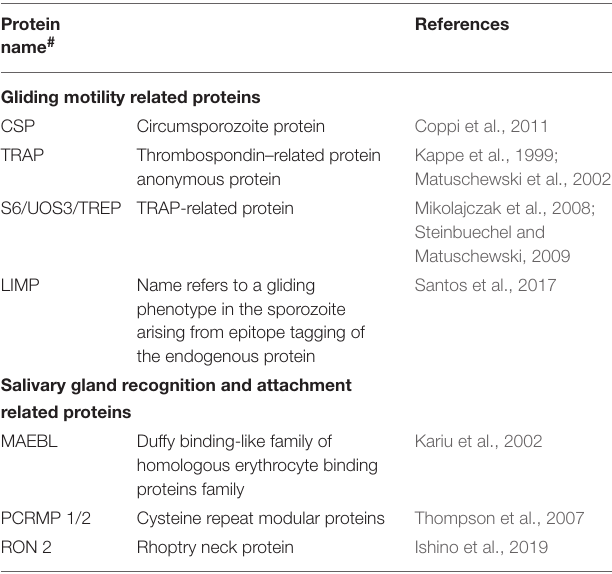
TABLE 2 | Known/suspected factors involved in Plasmodium salivary gland invasion